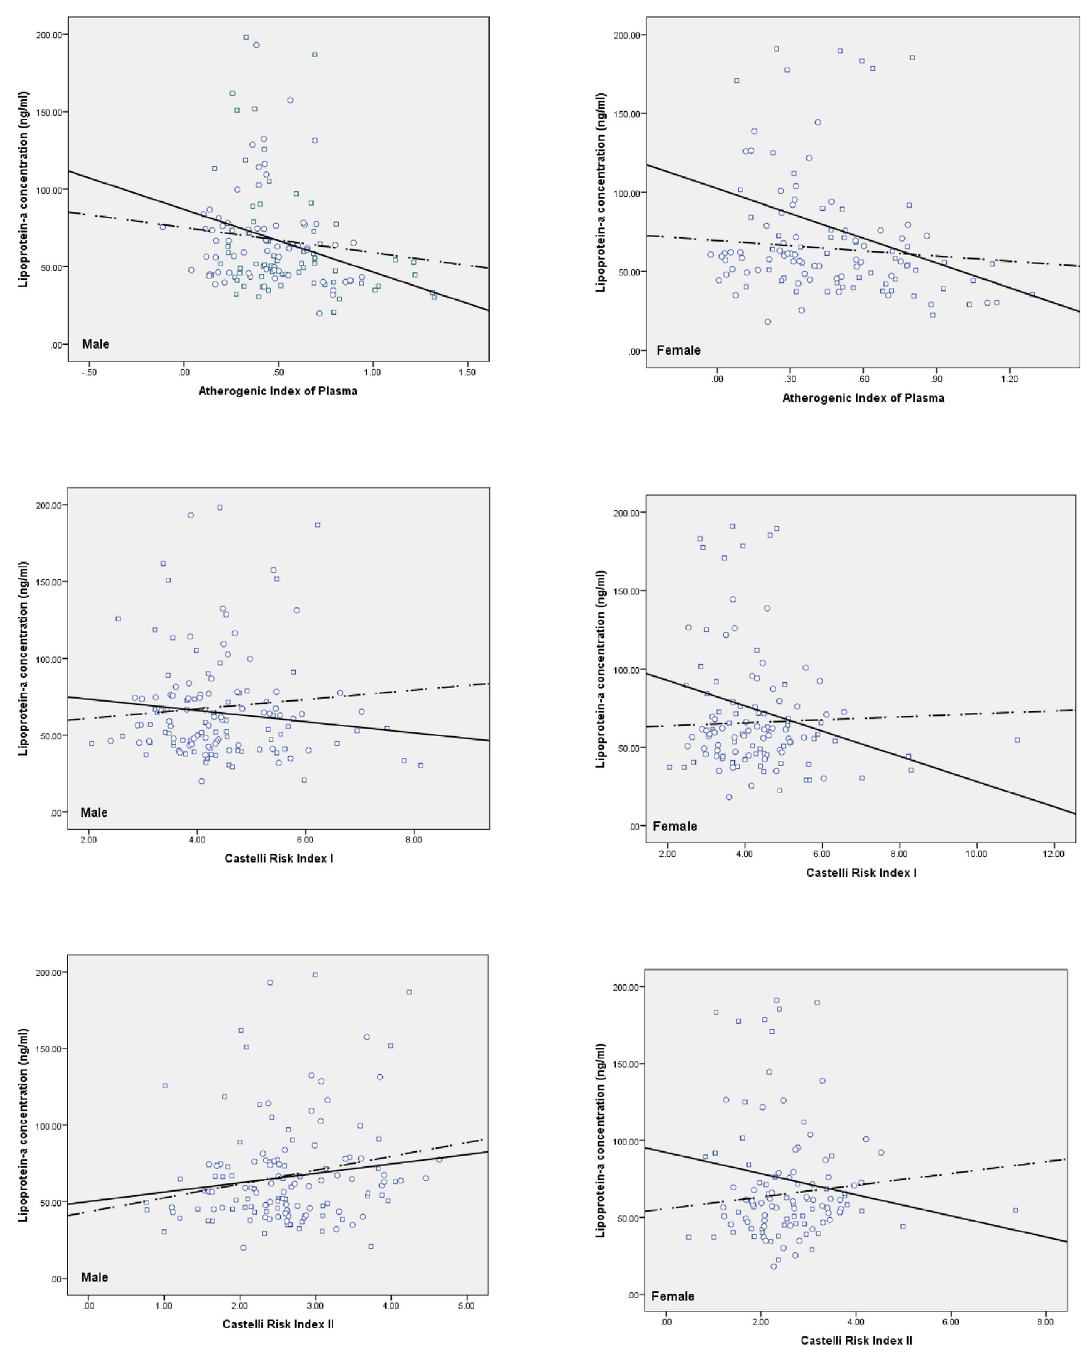
Fig 1. Correlation � of Lipoprotein (a) with Atherogenic Indices of Plasma¶ according to both genders. Control: circle; Case: square; Control regression line: dashed line; Case regression line: solid line. Atherogenic Index of Plasma (AIP); Castelli Risk Index I (CRI I); Castelli Risk Index II (CRI II). females than case males significantly increased with the highest dichotomy of C-Peptide. The gender difference might occur in many studies. In one study, the relative risks of T2DM, dysli- pidemia, and hypertension for women were higher than for men in the incidence of MI [21].